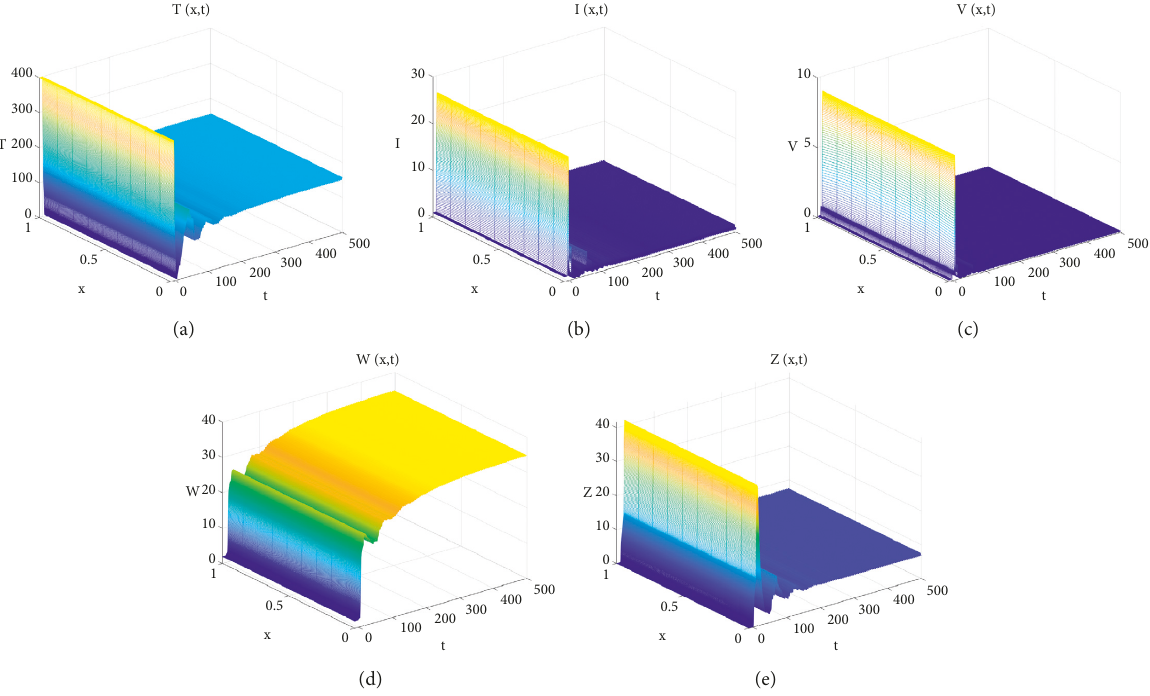
Figure 5: Taking β � 0 . 45, β � 0 . 01, c � 0 . 16, m � 0 . 01, δ � 0 . 1, h � 0 . 01, a � 0 . 5, k � 4, and b � 0 . 15, we have 1 2 R � 1050 . 9 > 1 ,R � 18 . 6953 > 1, and R � 12 . 6831 > 1, E � ( 154 . 1877 , 1 . 0000 , 0 . 1000 , 35 . 0492 , 8 . 8477 ) is asymptotically 0 3 4 4